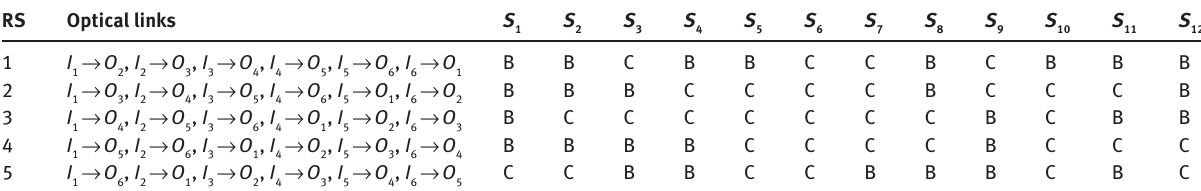
Table 1: States of the 12 switching units in selected five routing states of the six-port optical switch which cover its 30 optical links. RS Optical